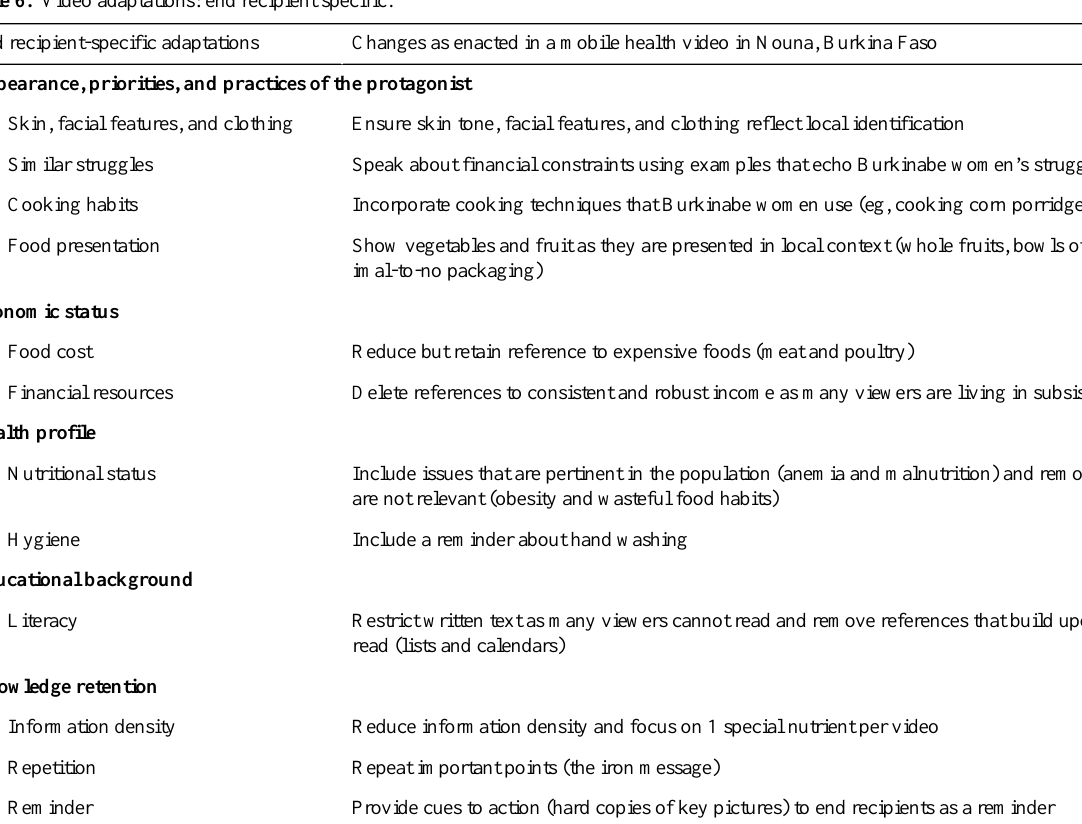
Changes as enacted in a mobile health video in Nouna, Burkina FasoEnd recipient-specific adaptations Ensure skin tone, facial features, and clothing reflect local identificationSkin, facial features, and clothing Speak about financial constraints using examples that echo Burkinabe women’s strugglesSimilar struggles